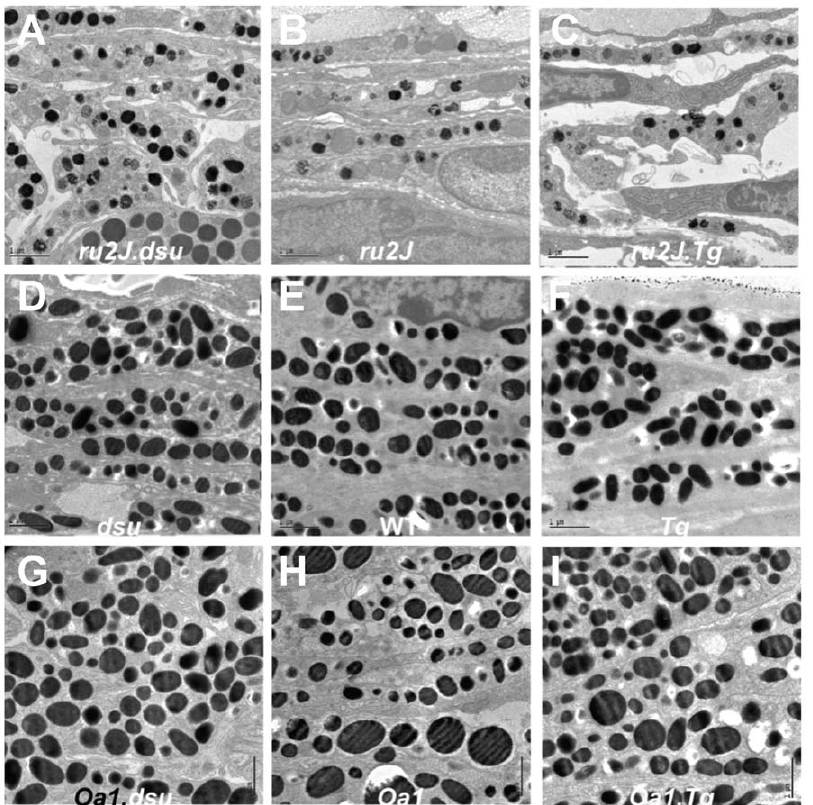
Figure 4. Loss of melanoregulin function partially rescues melanosome size and density in the choroid of Hps5 ru2J mutant mice. A–I: Electron microscopic images of the pigment choroid layer in mice of the genotypes indicated. Orientation is with RPE toward the top of each image. Abbreviations: ru2J=Hps5 ru2J ; dsu=Mreg dsu ; WT=wildtype; Tg=Mreg Tg ; Oa1=Oa1 ko . Scale bar=1 m m.